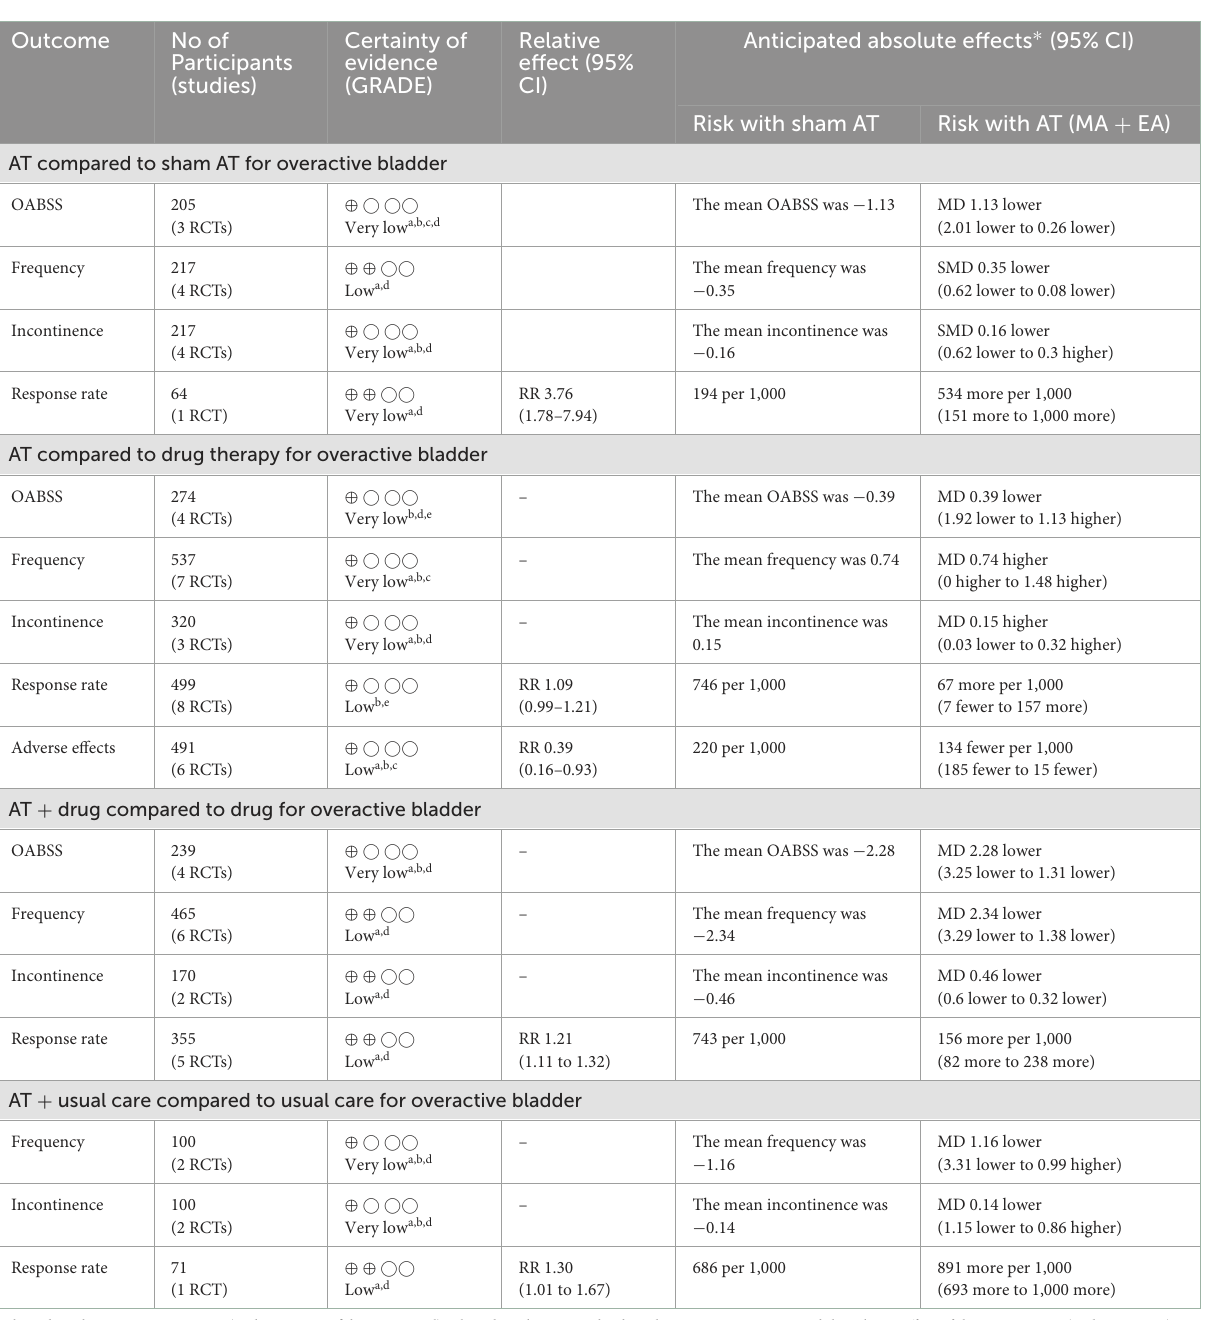
TABLE 2 Summary of findings.